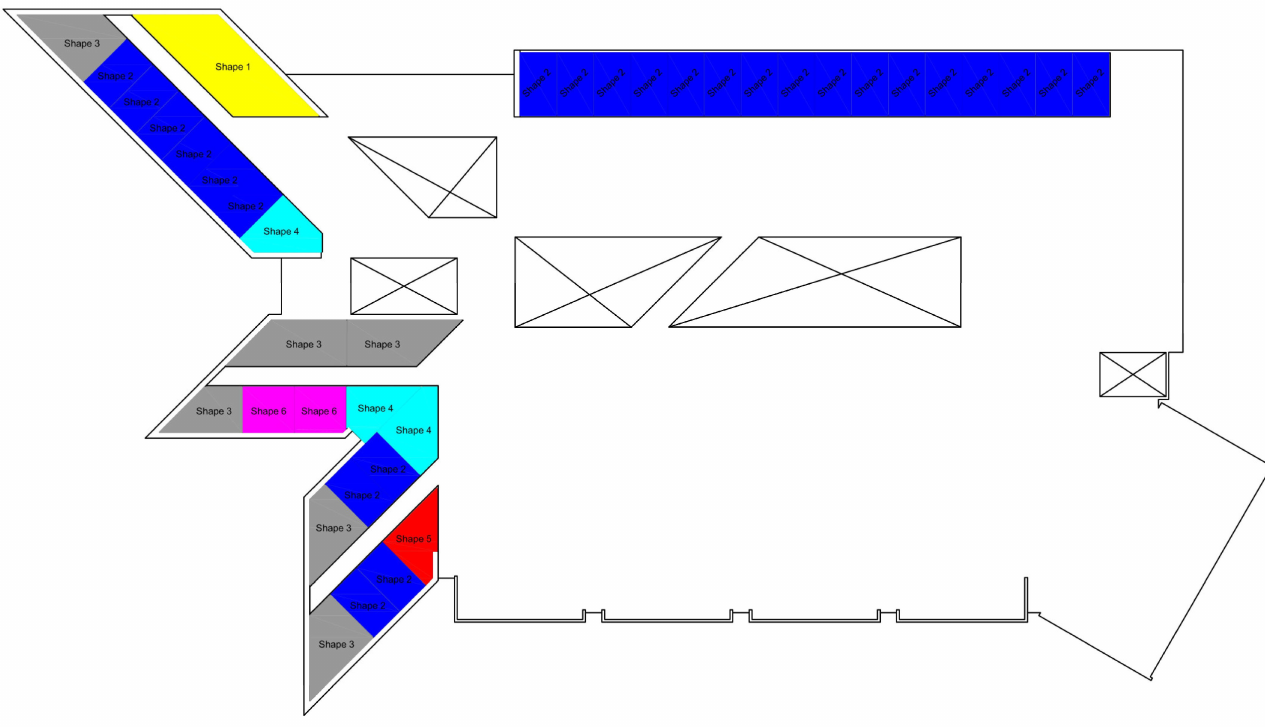
Figure 4. Selected